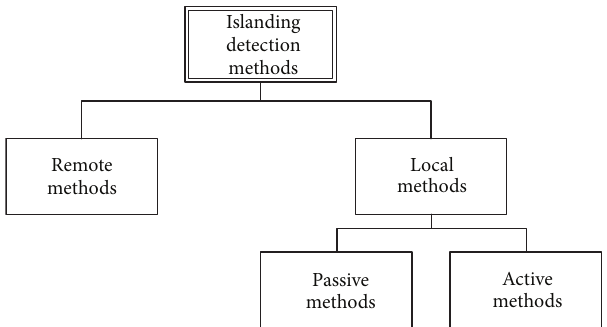
Figure 1: Classification of islanding detection methods.